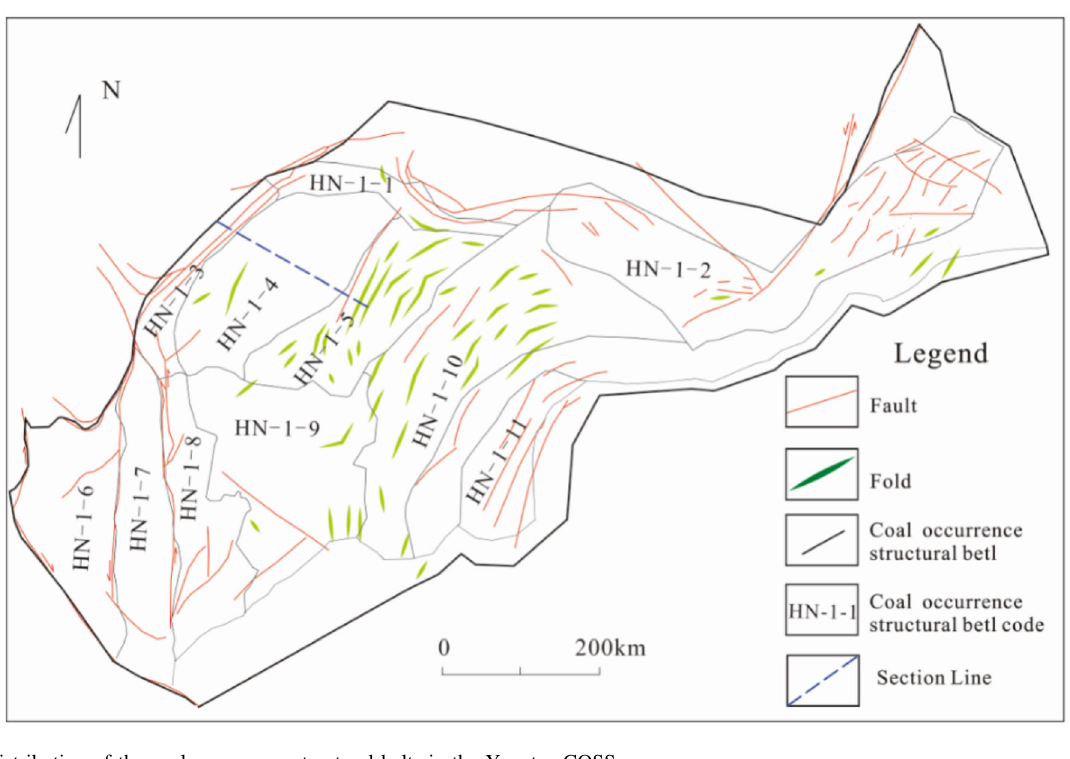
Fig. 8 Distribution of the coal occurrence structural belts in the Yangtze COSS